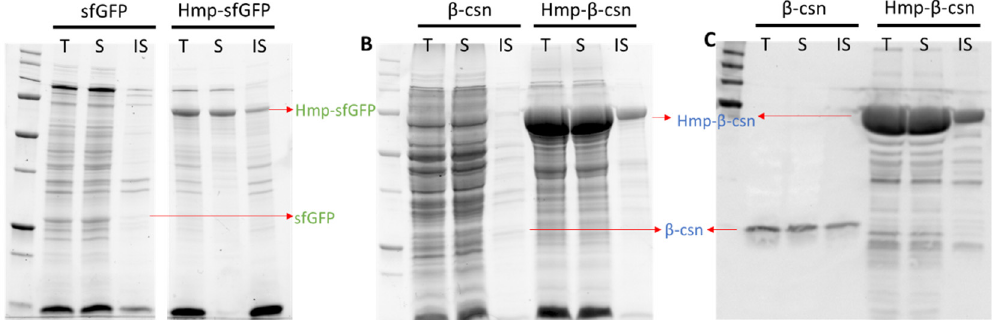
Figure 4. Solubility of sfGFP, Hmp-sfGFP, β -csn, and Hmp- β -csn. After 4 h induction with 1 mM IPTG at 37 °C, wild-type harboring pQE80-P T5 - gfp sf (pXW09), pQE80-P T5 - hmp-gfp sf (pXW08), pQE80-P T5 - β -csn (pXW13), pQE80-P T5 - hmp- β -csn (pXW12) were sonicated, centrifuged, and separated into soluble (S) and insoluble (IS) fractions. Protein fractions were resolved by SDS-PAGE and visualized through stain-free technique in ( A ), ( B ), and Western blot in ( C ). Note that ( B , C ) are from the same protein gel. Arrows indicate expected/observed positions of respective protein bands. Both Hmp- β -csn and β -csn contained C-terminal 6×His tags and Western blot was conducted with anti-His tag antibodies. (T) Total cell lysate from induced culture; (S) soluble fraction; (IS) insoluble fraction.